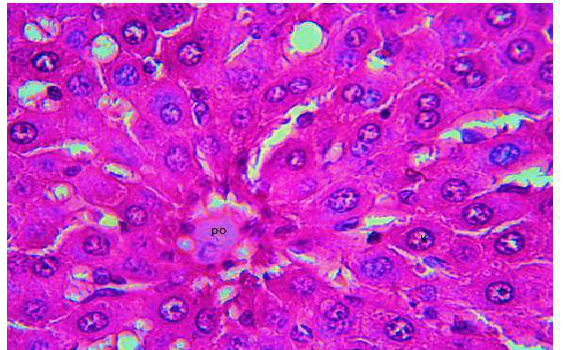
Figure, 1: Photomicrograph of a section of liver of C group, normal appearance portal area, po=portal area, K=kupffer cell. X40, E and H stain.